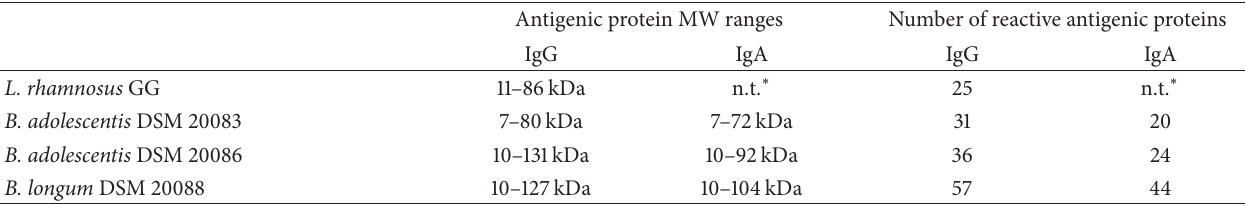
Table 1: Molecular weight ranges of proteins reacting with IgA and IgG antibodies and the number of detectable antigenic proteins present in different bacterial homogenates.